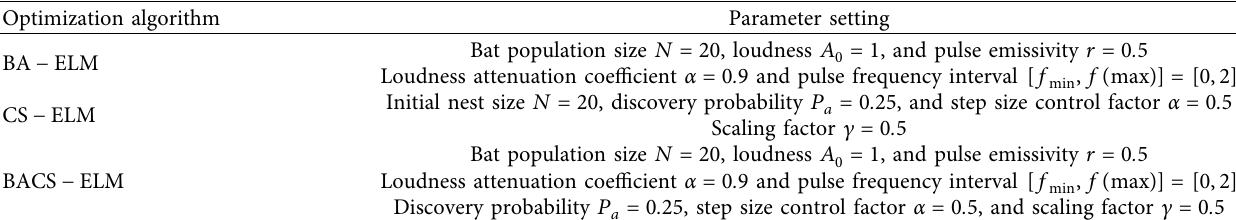
Table 3: The population parameter setting of three optimization methods. Optimization